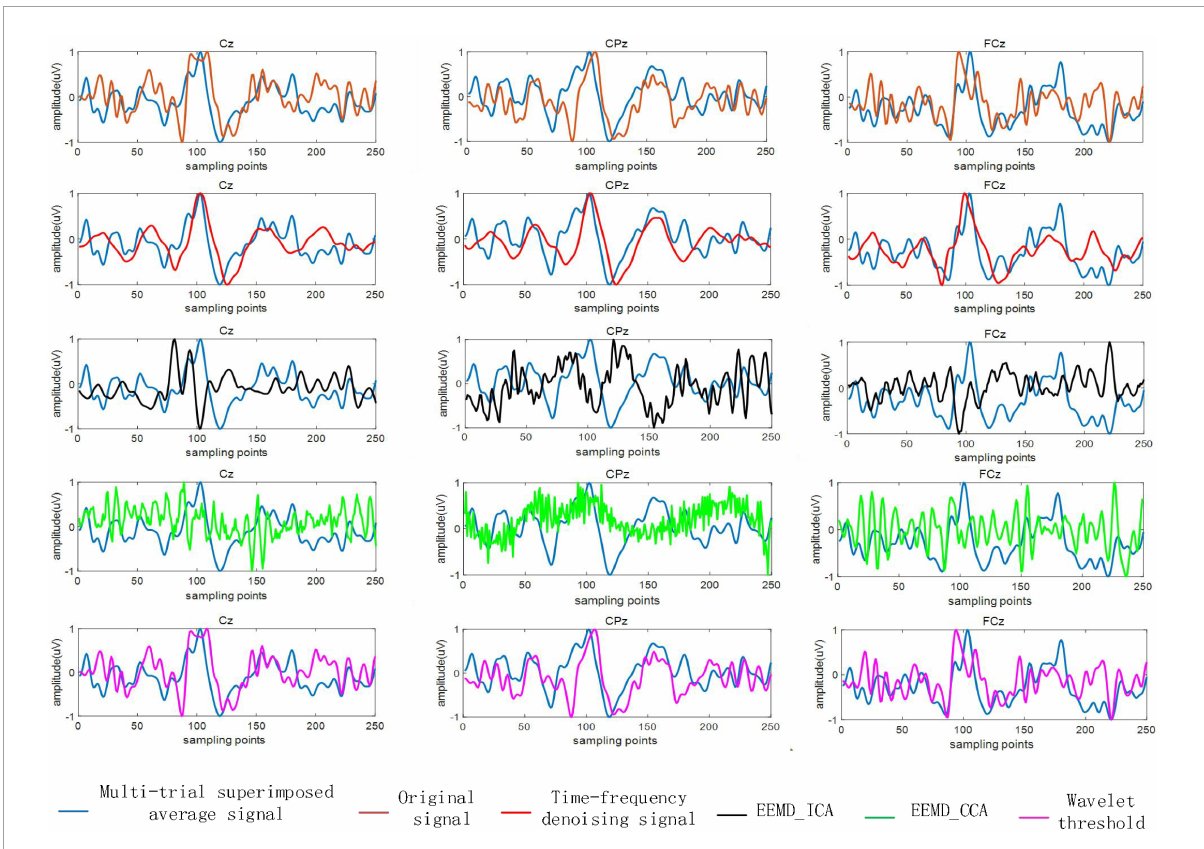
FIGURE6 The reference signal and the signal after denoising by the time-frequency denoising method, ensemble empirical mode decomposition (EEMD)-independent component analysis (ICA), EEMD-canonical correlation analysis (CCA), and wavelet threshold method.